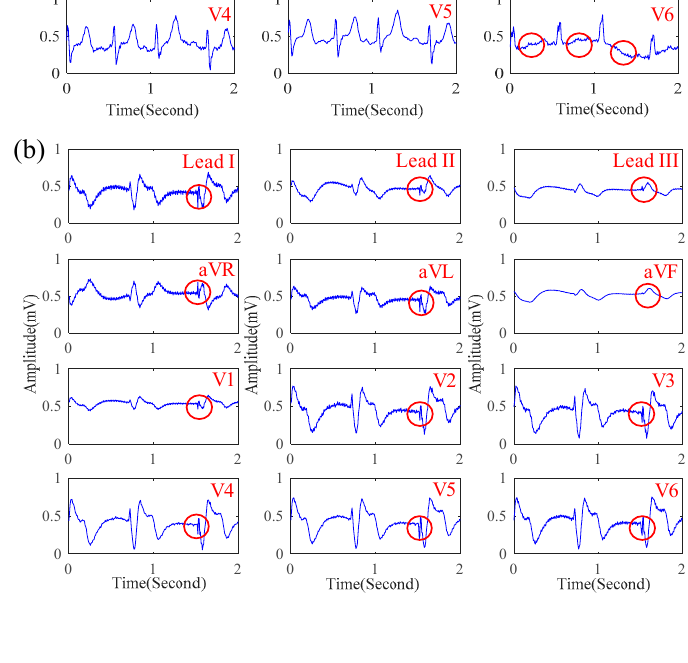
Figure 7. The 12-lead ECG signals obtained by the proposed system when ( a ) sitting and ( b ) walking.